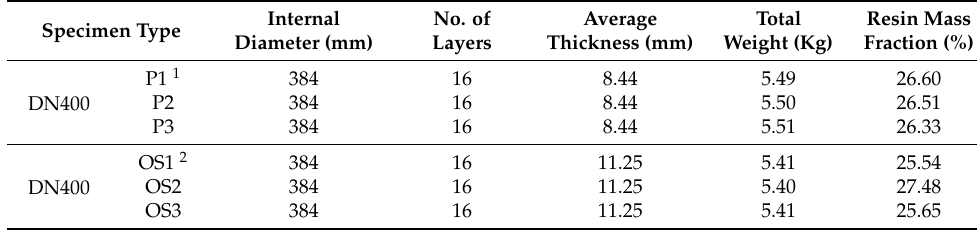
Table 3. GFRP pipe geometric